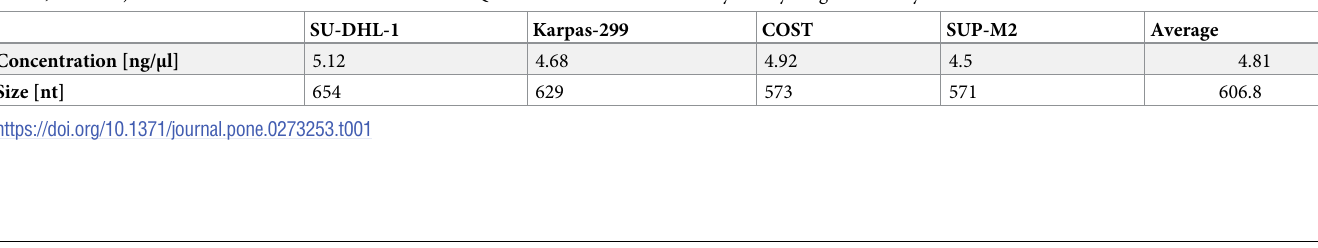
Table 1. Results of the library preparation. Libraries for Nanopore sequencing were prepared of 4 anaplastic large-cell lymphoma cell lines (SU-DHL1, Karpas-299, COST, SUP-M2). The concentration was measured with the Qubit BR dsDNA kit and library size by Fragment Analyzer with the hs NGS